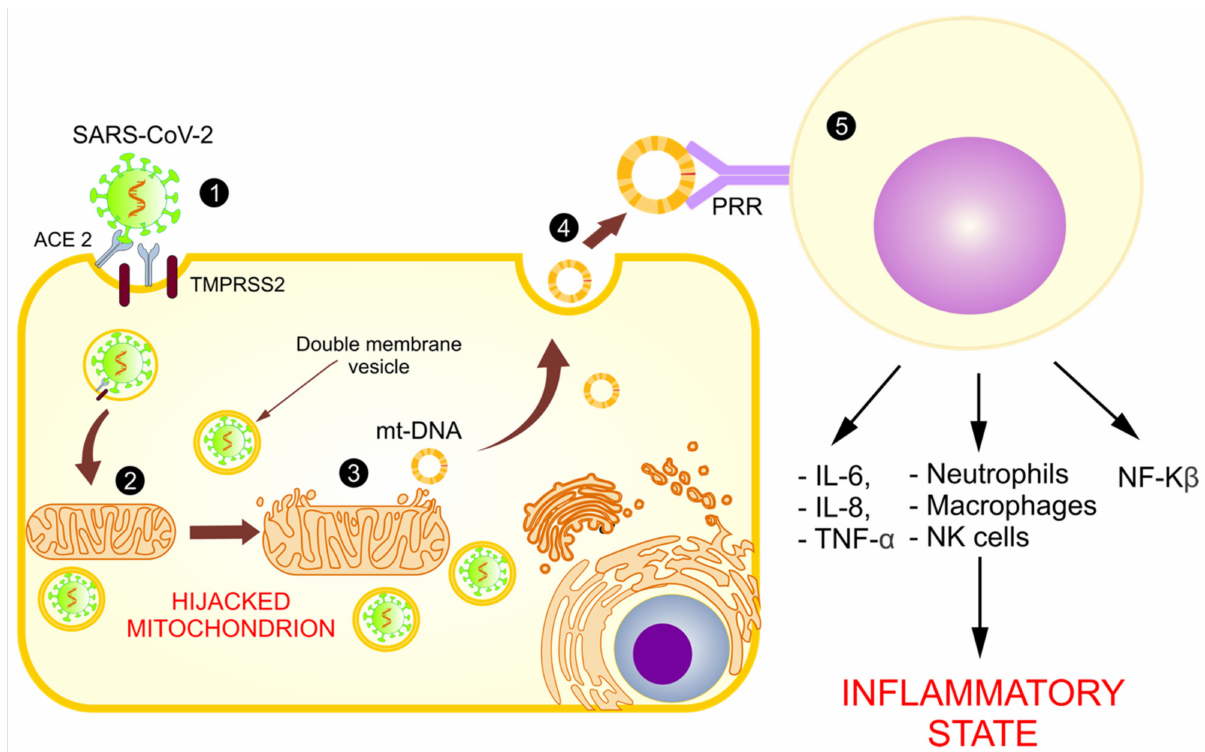
Figure 4. Use of mitochondria for SARS-CoV-2 replication and the release of mt-DNA into the circulation. The figure shows the introduction of SARS-CoV-2 into the host cell (1) and the hijacking of the mitochondrion for its replication (2), causing a loss of its membrane and the release of mt-DNA into the cytosol (3) and circulation (4), activating the immune system (5), and increasing the inflammatory